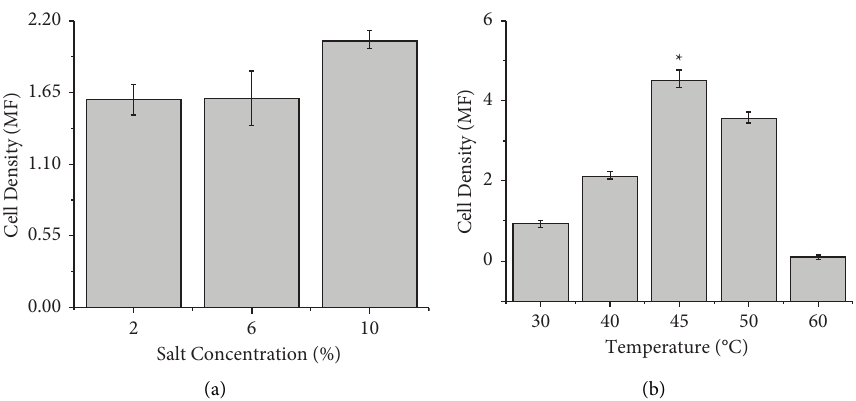
Figure 6: Comparison of cell density of B. amyloliquefciens BKHE (a) in diferent salt concentrations and (b) at diferent temperatures